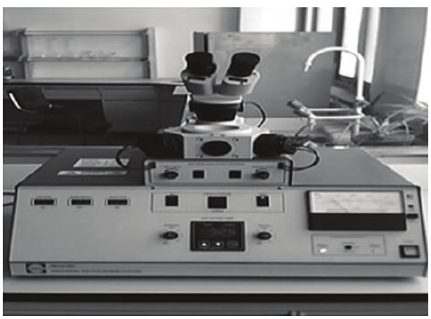
Figure 3: Ion reduction of thickness